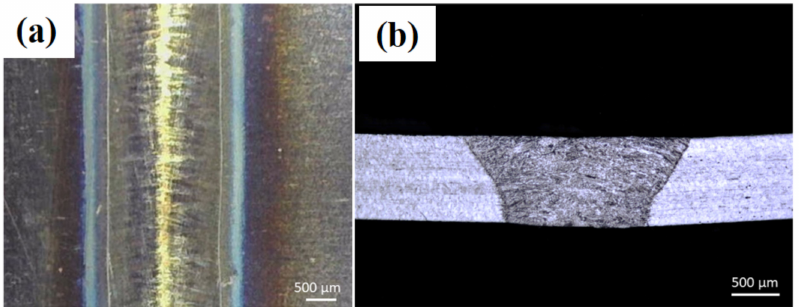
Figure 6. Optical images of laser-welded 0.5 mm thick sheets’ cross-sections without powder addition and with laser power = 1000 W, laser scanning speed = 2.4 m/min, gas flow rate = 5 slpm, and robot tilt angle = 0 ◦ : ( a ) top view and ( b )